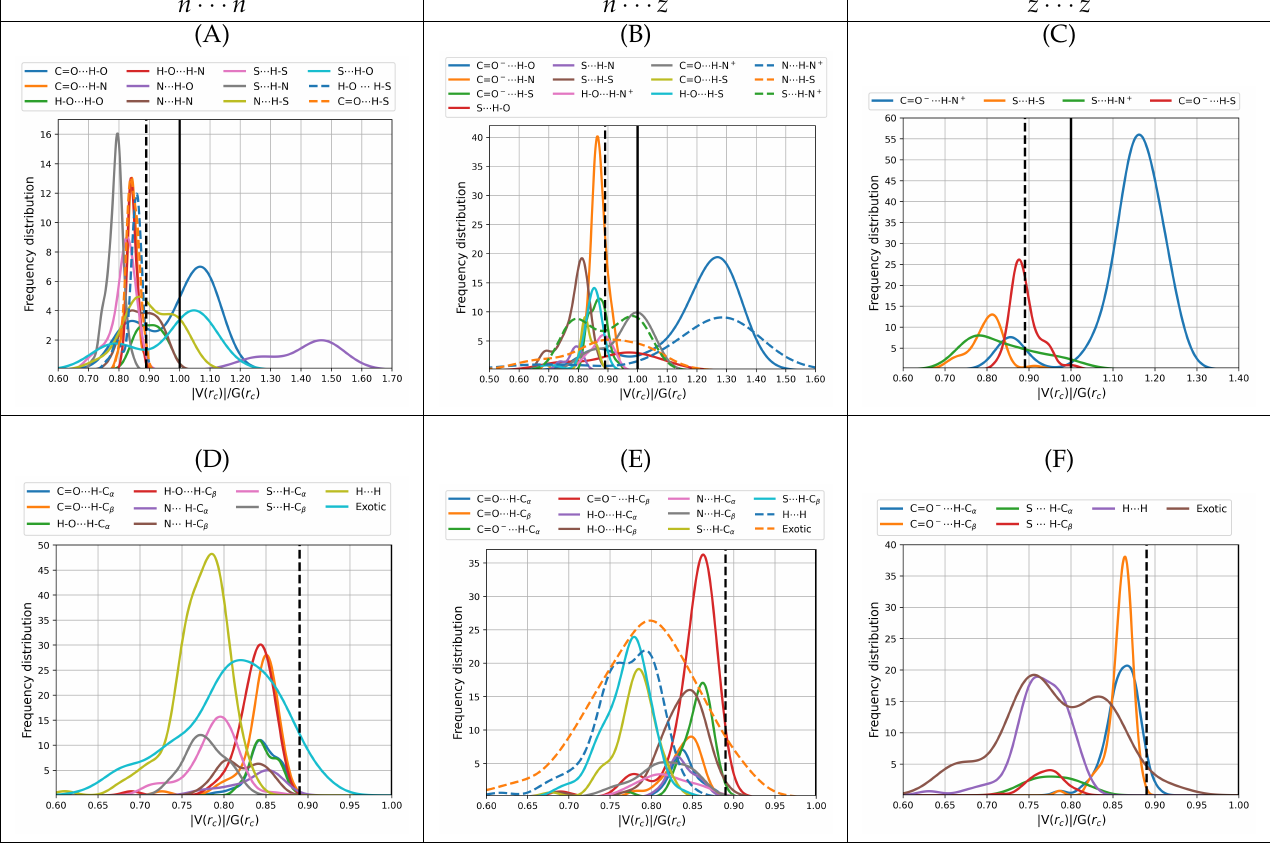
Figure 7. Virial ratios at bond critical points for intermolecular contacts for all dimers of cysteine found in this work. The top row shows only primary hydrogen bonds including salt bridges. The bottom row shows secondary hydrogen bonds, dihydrogen bonds, and all exotic interactions. The left column is reserved for the n · · · n dimers (subfigures ( A , D )), the middle column for n · · · z (subfigures ( B , E )) and the right column for z · · · z (subfigures ( C , F )). All values taken from the B3LYP–D3/6– 311++G( d , p ) potential energy surfaces with water represented as a continuum solvent. Vertical solid lines mark the QTAIM boundaries separating long range from intermediate character interactions. Dashed vertical lines mark the reference value for the gas phase water